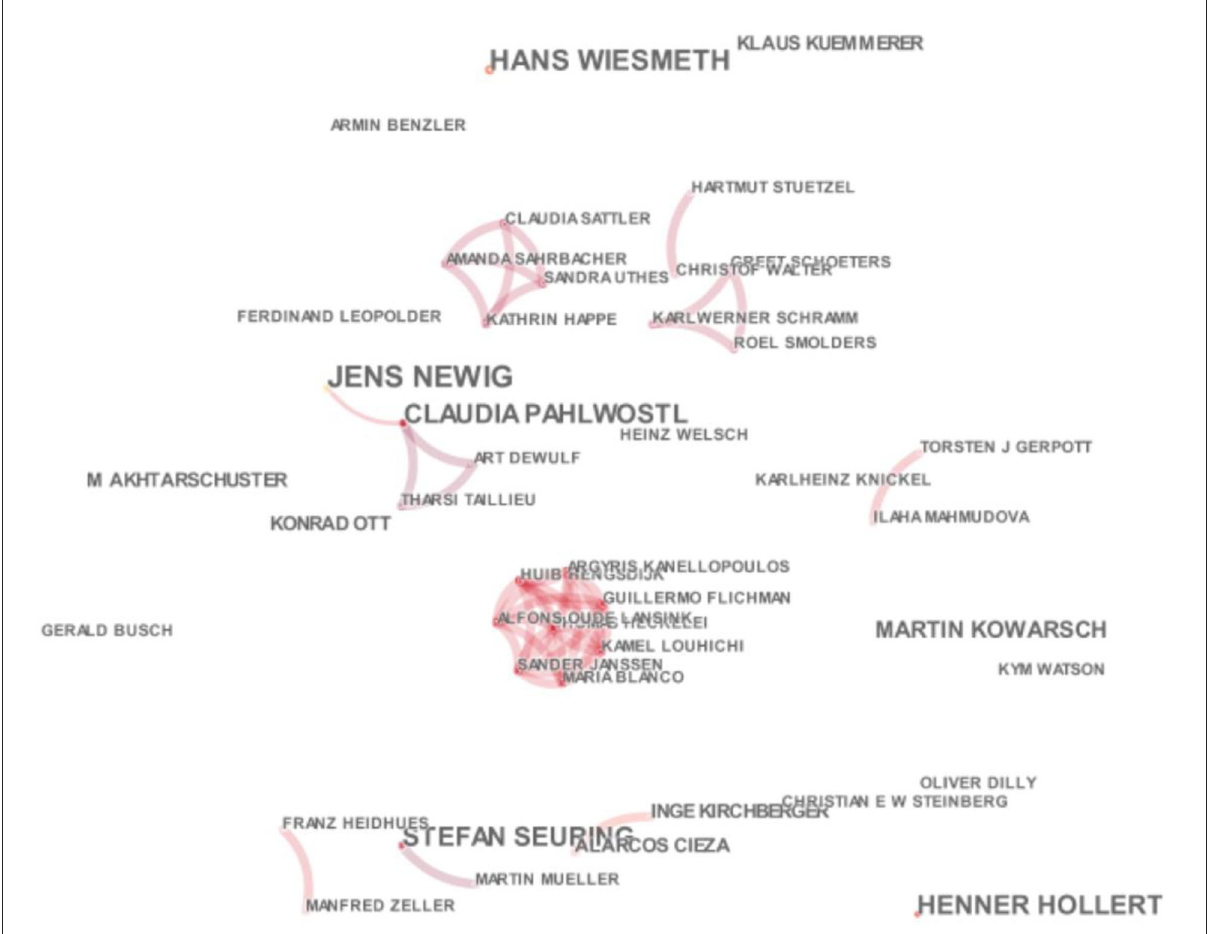
FIGURE5 Cooperation network of German environmental researchers. Source: This map was drawn by the author through CiteSpace.